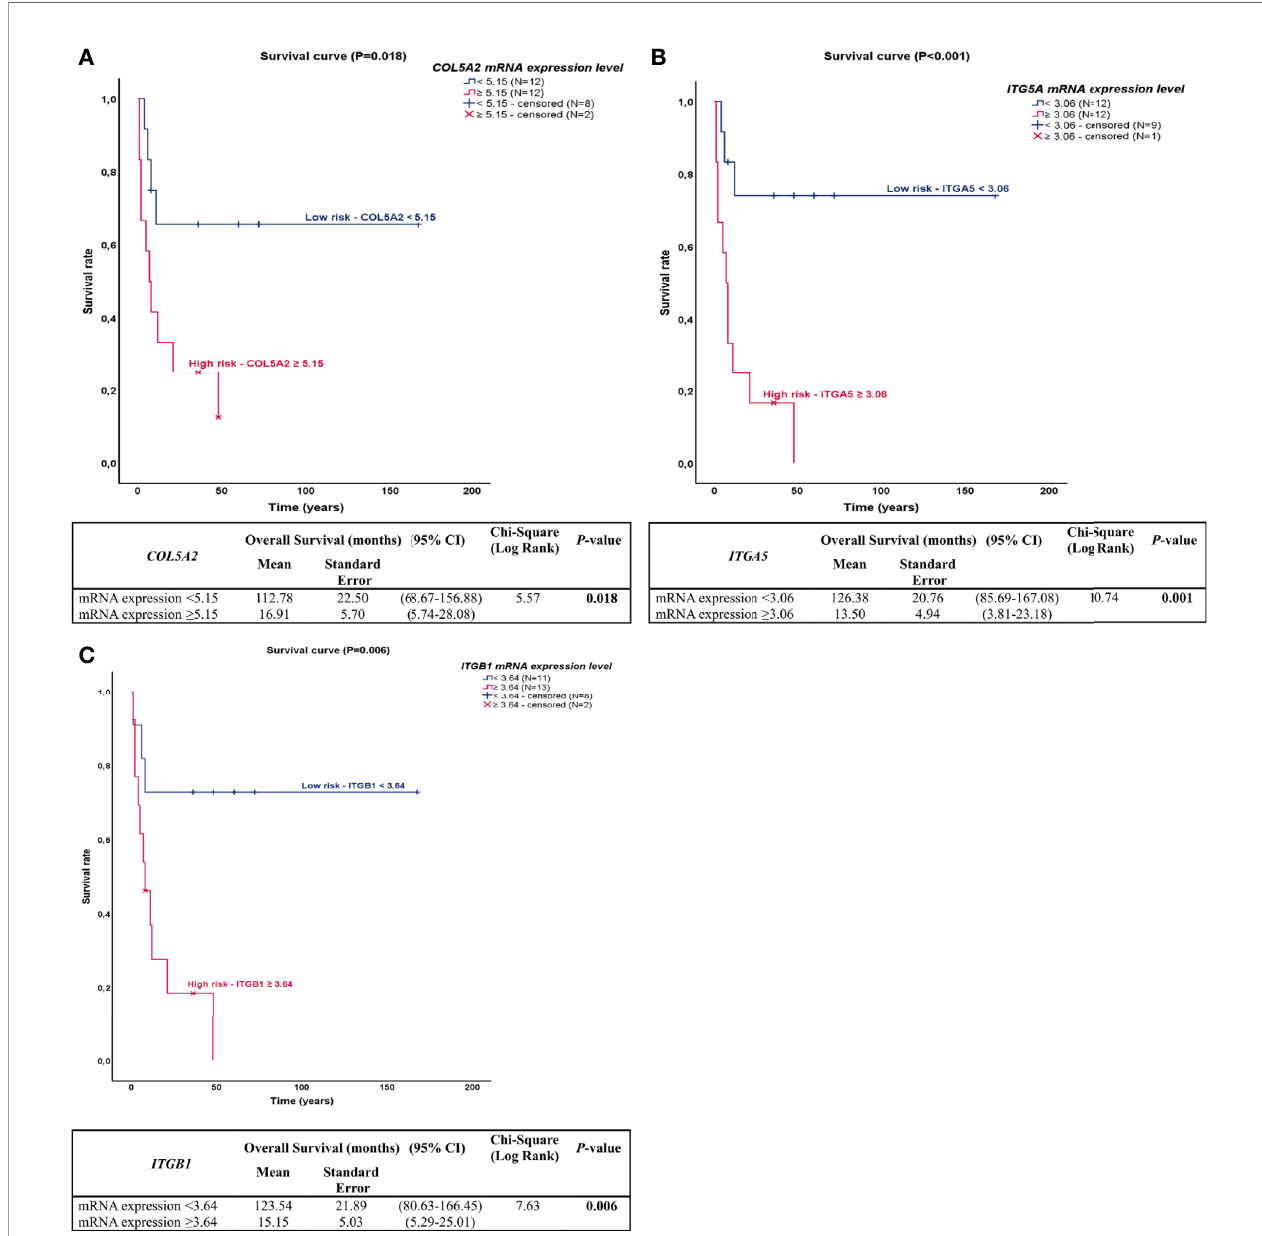
FIGURE 2 | Kaplan-Meier plots for overall survival for PNEN patients according to the difference in COL and ITG gene expressions. (A) In the Kaplan-Meier survival curve of COL5A2 , patients who had high expression (top of the curve) presented lower survival rate than those who had lower expression (bottom of the curve), 112.78 vs 16.61 months, (P=0.018); (B) In the Kaplan-Meier survival curve of ITGA5 , patients who had high expression (top of the curve) presented lower survival rate than those who had lower expression (bottom of the curve), 126.38 vs 13.50 months, (P=0.001); (C) In the Kaplan-Meier survival curve of ITGB1 , patients who had high expression (top of the curve) presented lower survival rate than those who had lower expression (bottom of the curve), 123.54 vs 15.15 months,